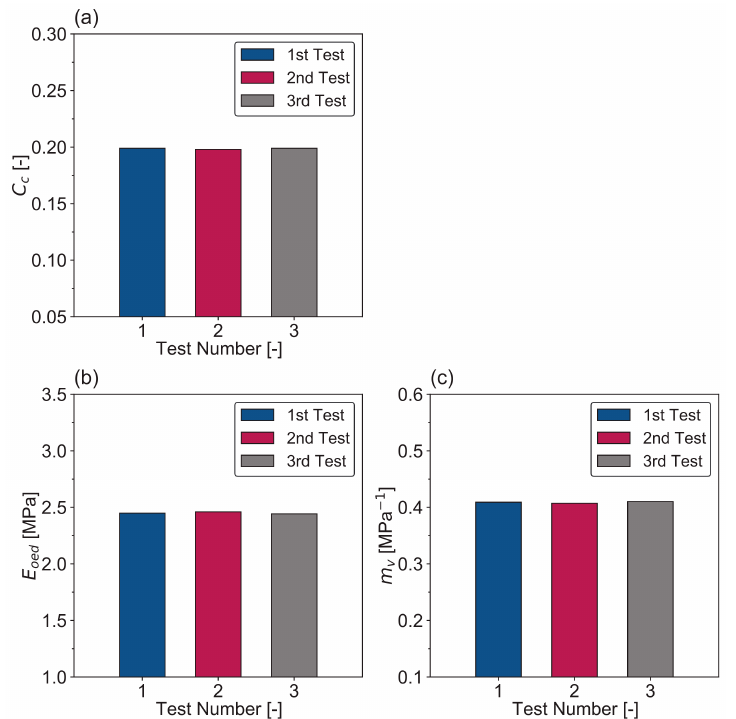
Figure 10. The compressibility parameters of samples during oedometer tests: ( a ) C c , ( b ) E oed and ( c ) m v